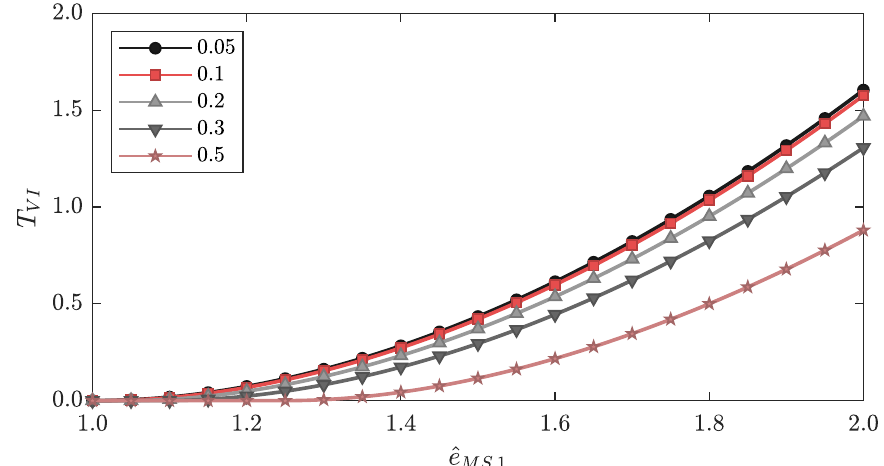
Figure 4. Resulting test statistic T VI of the variance inflation (VI) approach (54) as a function of the residual ˆ e MS ,1 for various ratios of σ w / σ 1 .